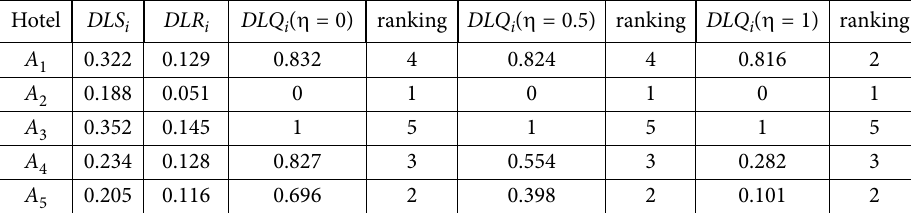
Table 5. The different ranking results with different parameters h Hotel